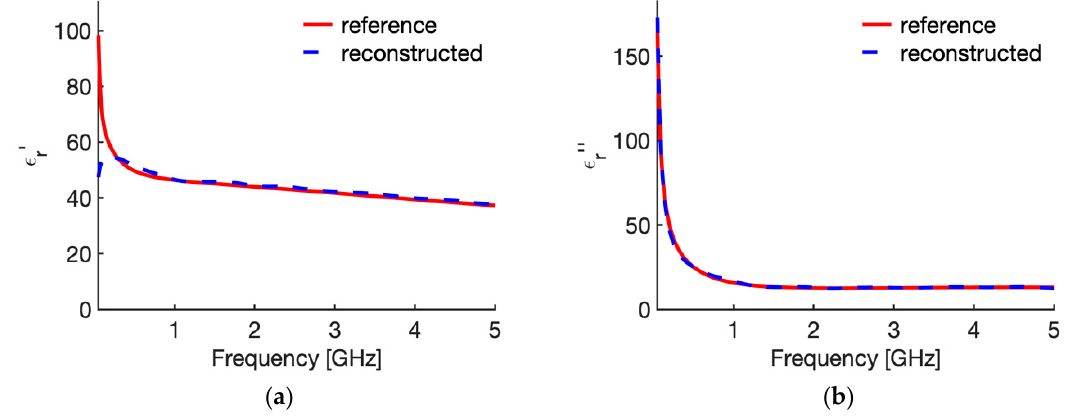
Figure 3. Relative complex permittivity of liver at 25 °C. ( a ) real part; ( b ) imaginary part. The values implemented into the CST software (red line) are compared with those reconstructed by the Stuchly’s model (dashed blue line) from the simulated reflection coefficient of the open probe.